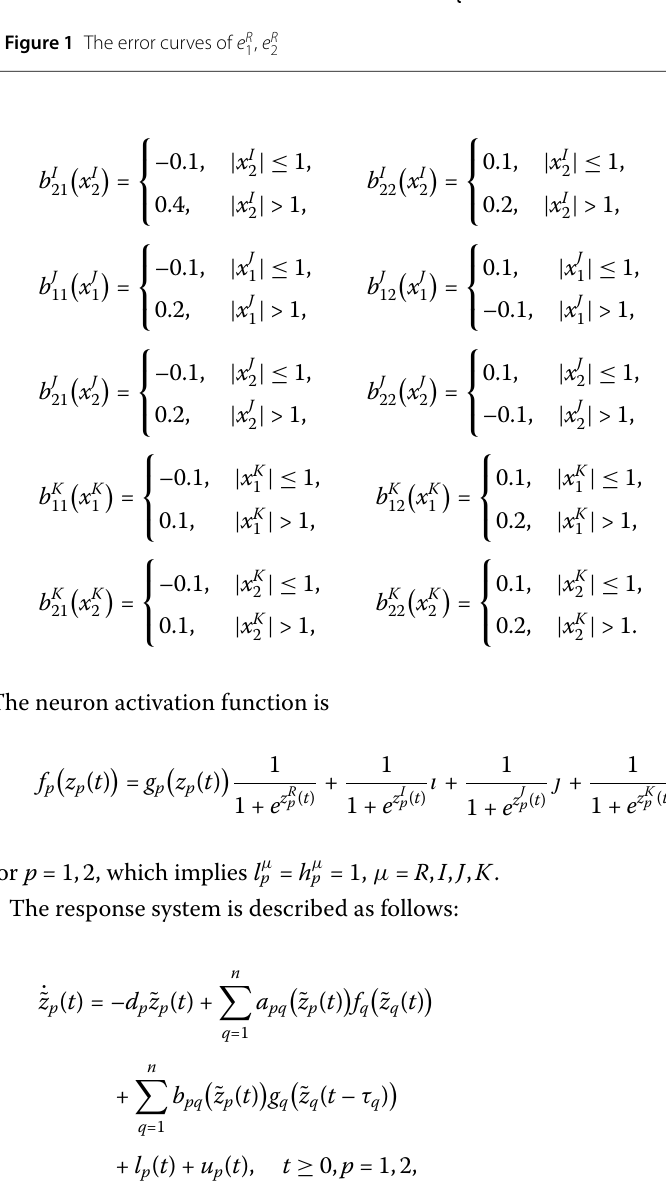
Figure 1 The error curves of e R 1 , e R